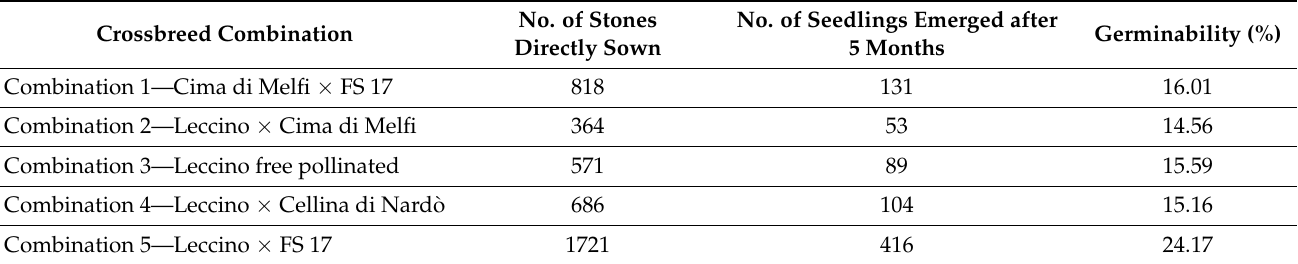
Table 2. Germination rates of the olive stones directly sown for the different cross combinations